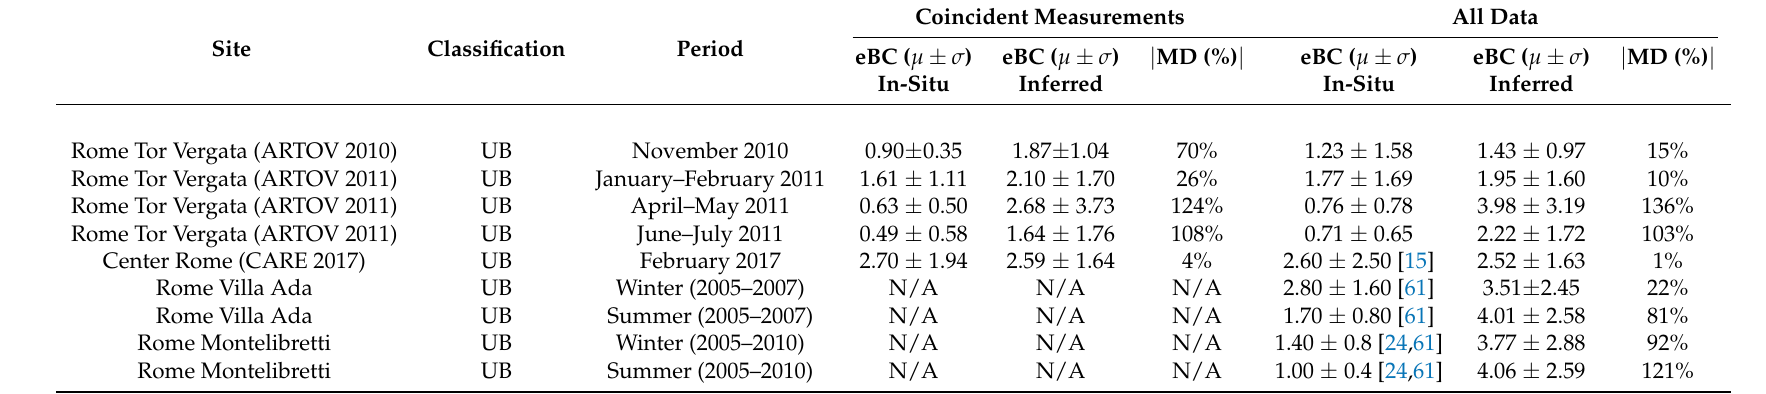
Table 4. Comparison of results from various sites: measurement site (name of the campaign), its classification (UB = urban background), measurement period, mean ( µ ) and standard deviation ( σ ), and mean differences (MD) of in-situ measured and AERONET inferred surface eBC mass concentrations during intensive field campaings performed in Rome. MD is calculated using Equation (8). Note that we show both values measured during all the field (all data) and a subset of these measured only when AERONET data were available (coincident measurements). N/A = not available